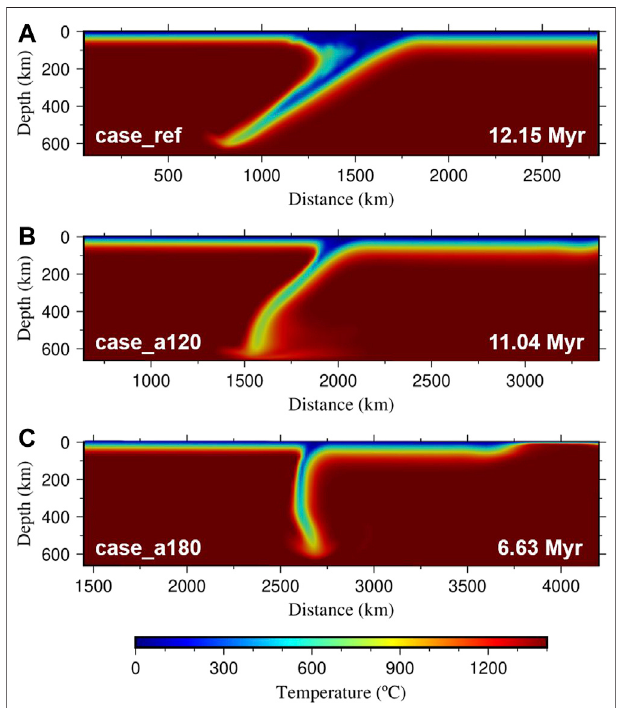
FIGURE 9 | Temperature fi eld along pro fi le CC ’ ( Figure 2A ) in case_ref (at 12.15 Myr) (A) , case_a120 (at 11.04 Myr) (B) , and case_a180 (at 6.63 Myr) (C)